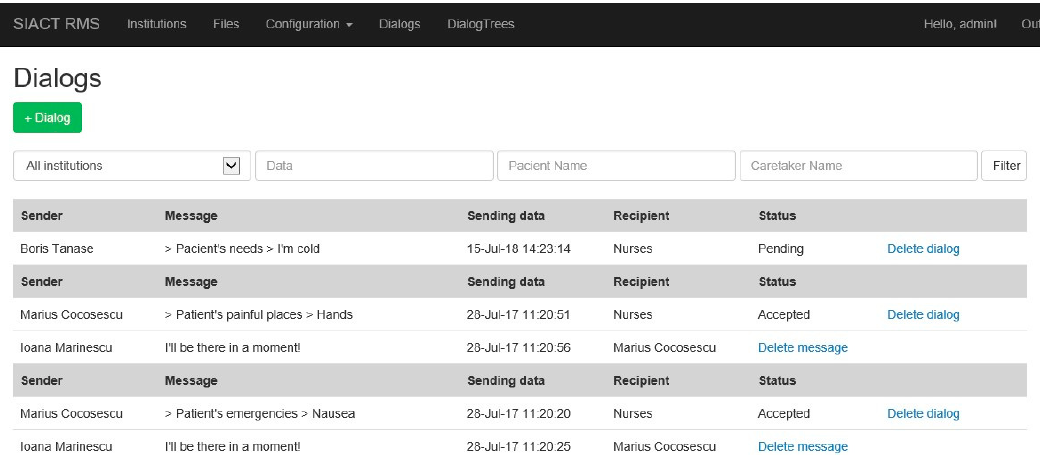
Figure 17. Data values provided by sensors mounted on the patient and recorded in the Server database.